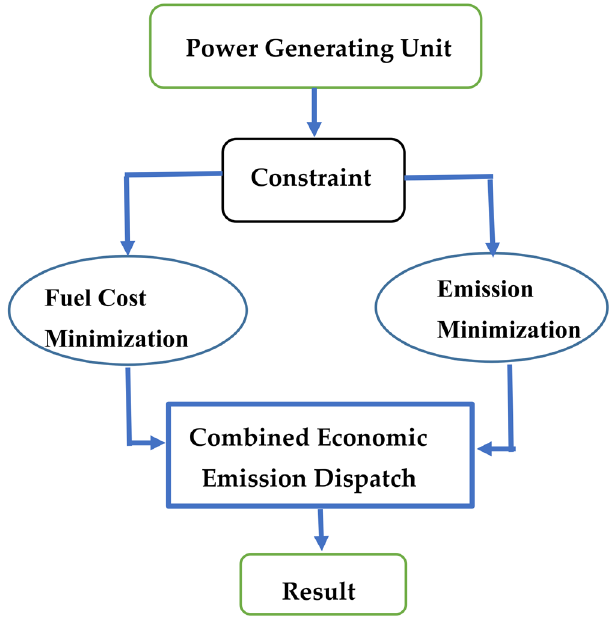
Figure 2. CEED presentation.